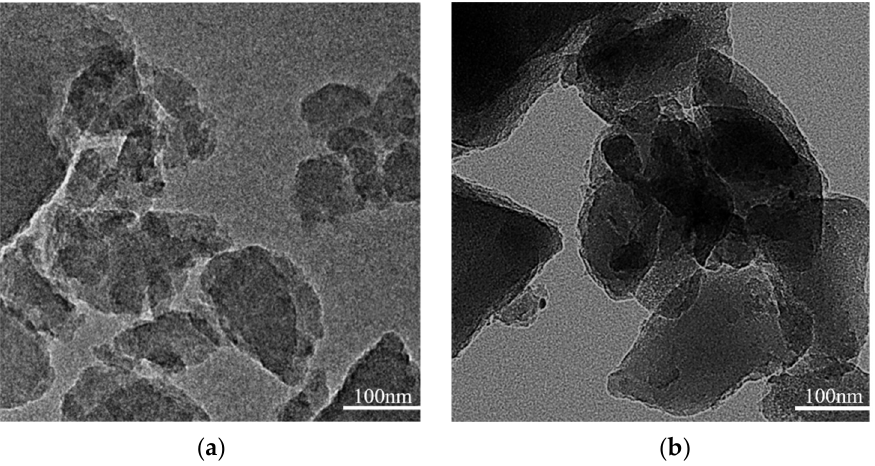
Figure 7. TEM images of ZrO 2 -MSiO 2 materials with n Zr = ( a ) 0 and ( b ) 0.15.